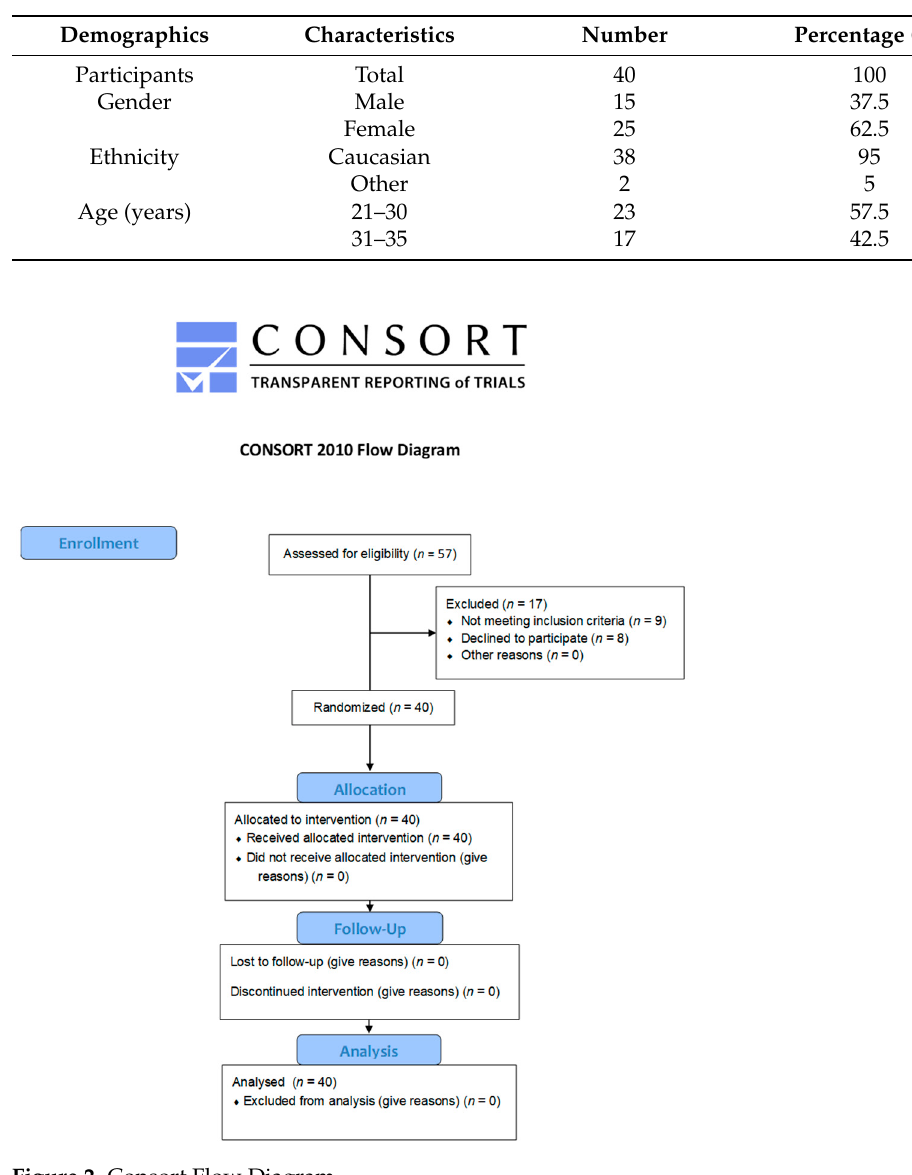
Figure 2. Consort Flow Diagram.